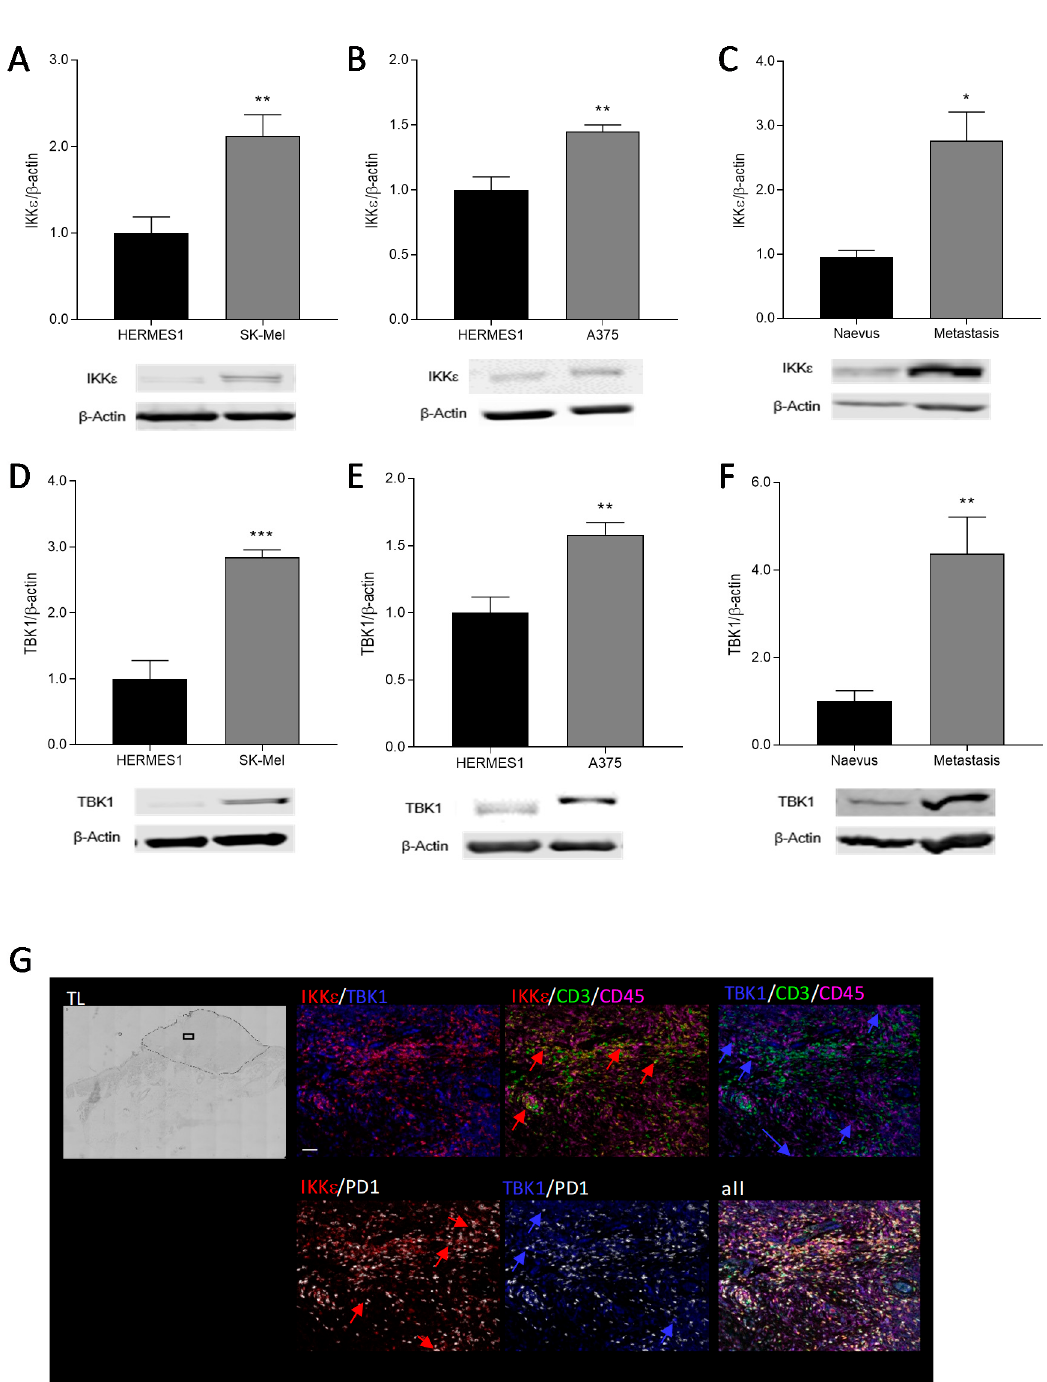
Figure 1. IKK ε and TBK1 protein expression in human cells and tissues. ( A ) IKK ε protein expression in human extended-replication melanocytes (HERMES)1 (black) and SK-Mel-28 melanoma cells (dark grey) ( n = 5–7), ( B ) in HERMES1 (black) and A375M melanoma cells (dark grey) ( n = 4) and ( C ) in human tissue from healthy naevi (black) in comparison to melanoma metastasis (dark grey) ( n = 9– 12). ( D ) TBK1 protein expression in human HERMES1 melanocytes (black) and SK-Mel-28 melanoma cells (dark grey) ( n = 6), ( E ) in HERMES1 (black) and A375M melanoma cells (dark grey) ( n = 8) and ( F ) in human tissue from healthy naevi (black) in comparison to melanoma metastasis (dark grey) ( n